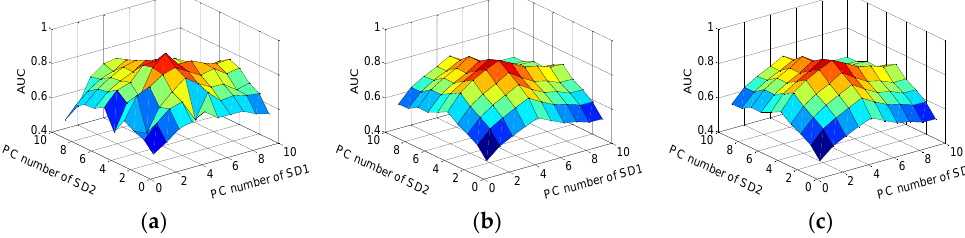
Figure 6. AUCs of Tucker decomposition-based TD with different numbers of spatial PCs: ( a ) CEM; ( b ) ACE; and ( c ) AMF.